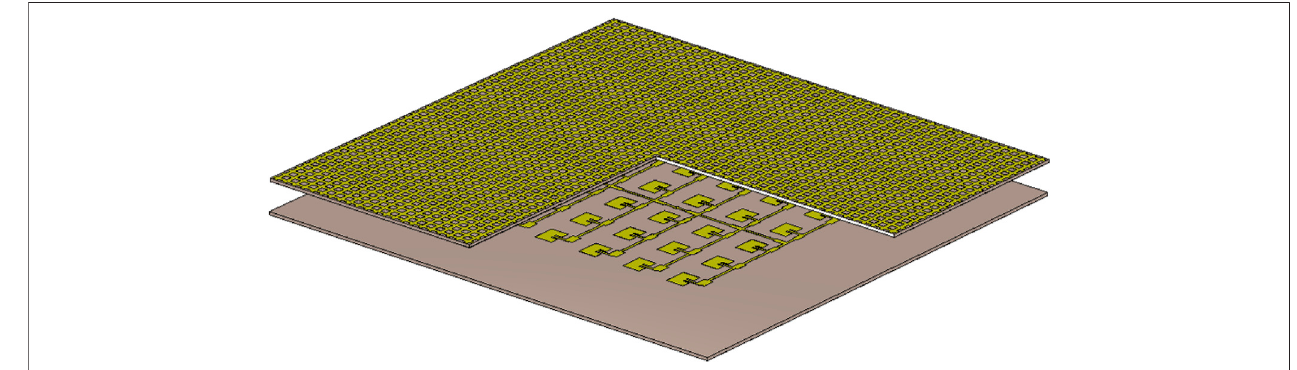
FIGURE 1 | Schematic diagram of the metamaterial antenna.